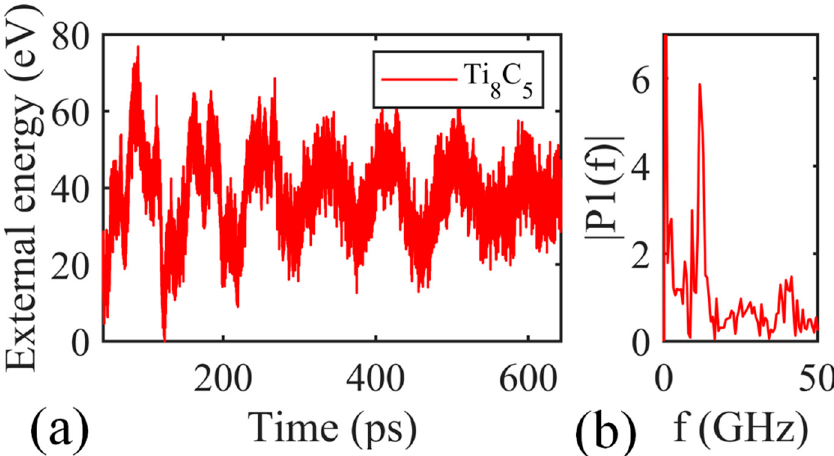
Figure 5. Oscillation of external energy of nanosheet after the separation of projectile and nanosheet. ( a ) External energy variation of Ti 8 C 5 over time period of 600 ps and ( b ) The corresponding frequency spectrum of Ti 8 C 5 over time period of 600 ps .